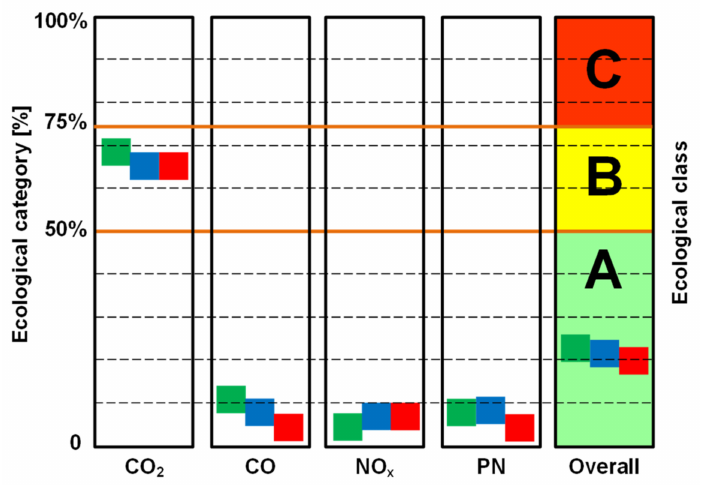
Figure 10. Value of the minimum road emission in the RDE test ( (cid:4) —vehicle A, (cid:4) —vehicle B, (cid:4) — vehicle C) obtained according to the algorithm for variable exhaust emission intensity; data provided in Tables